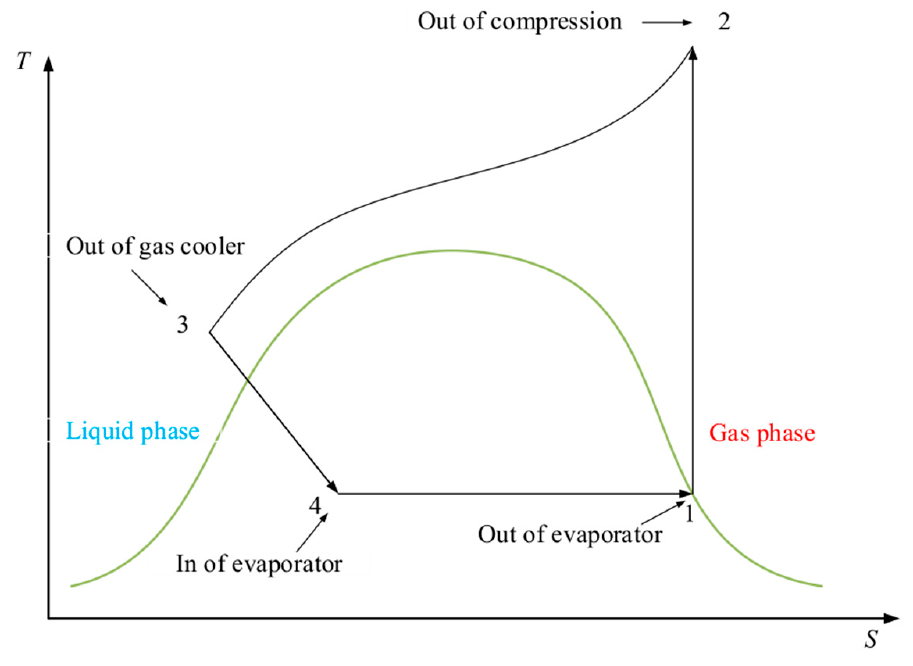
Figure 21. T-S diagram of the transcritical vapor compression heating working cycle. Table 6. Critical parameters of R744 and azeotropic refrigerant. Parameter Critical Pressure